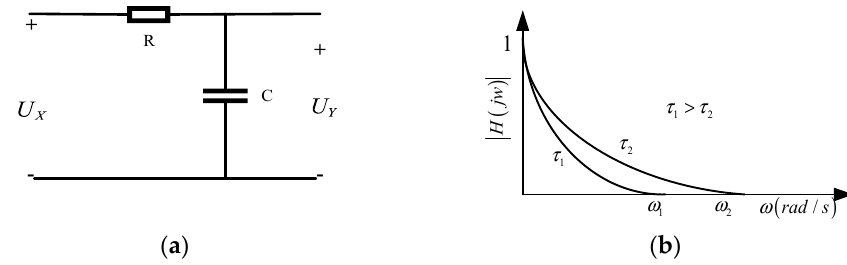
Figure 5. Schematic diagram of working status division ( a ) Battery; ( b ) Super capacitor.